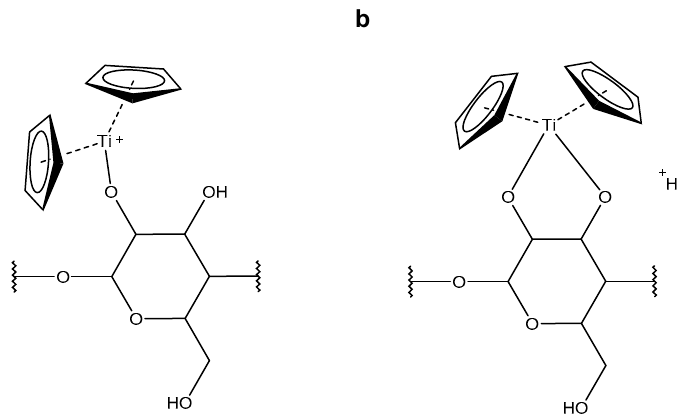
Figure 8. Possible interaction modes between titanocene and β -cyclodextrin: ( a ) formation of one covalent bond and the positive charge residing on the titanium; ( b ) formation of two covalent bonds with the charge emerging from an additional proton.